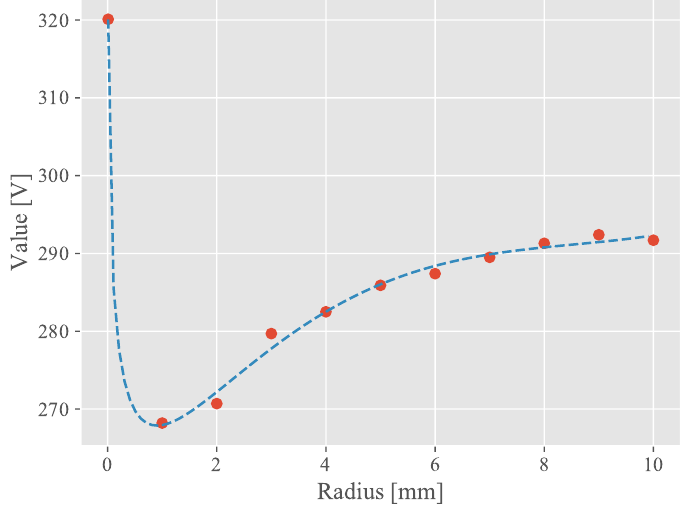
Figure 10. Proxy model with logarithmic transformation (blue line) applied to the data presented in Table 2 (red